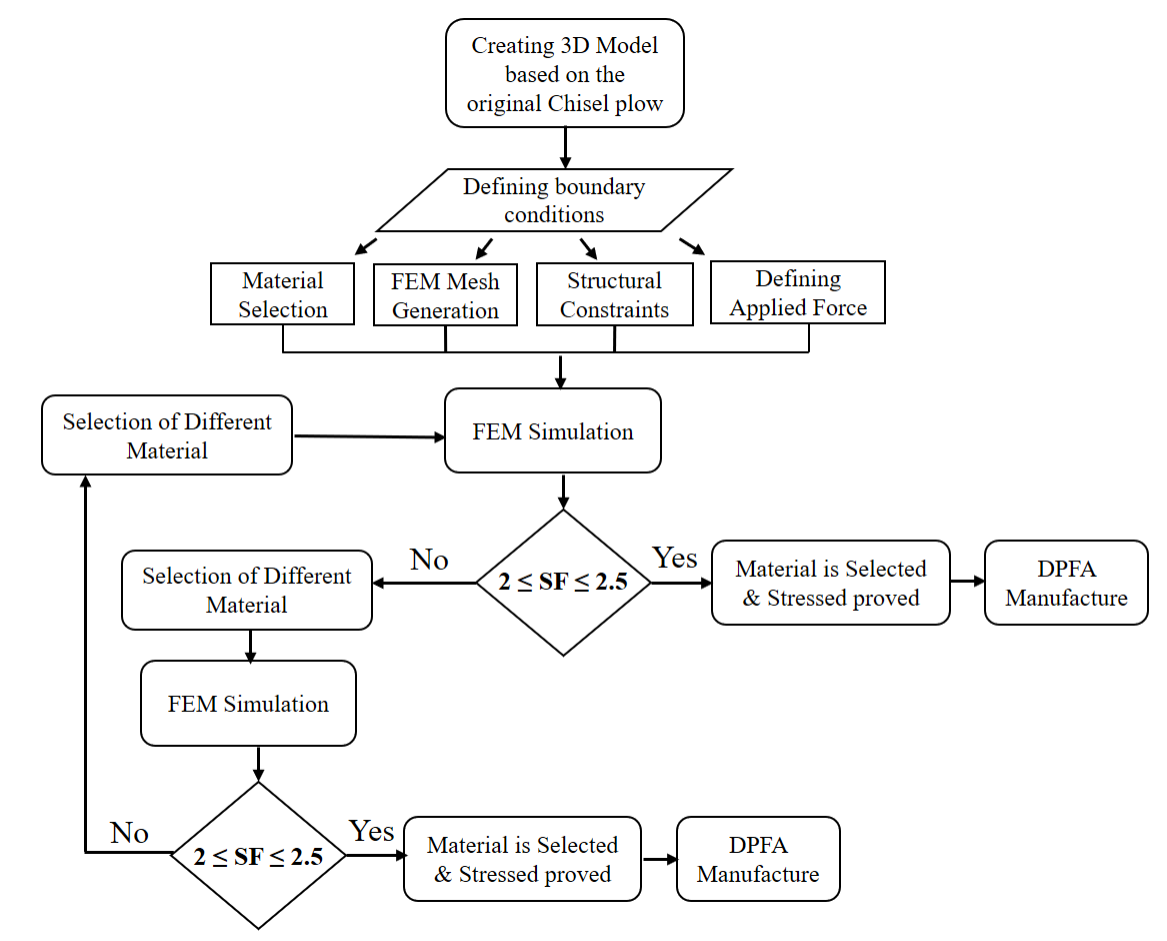
Figure 4: Flow chart of the DPFA design